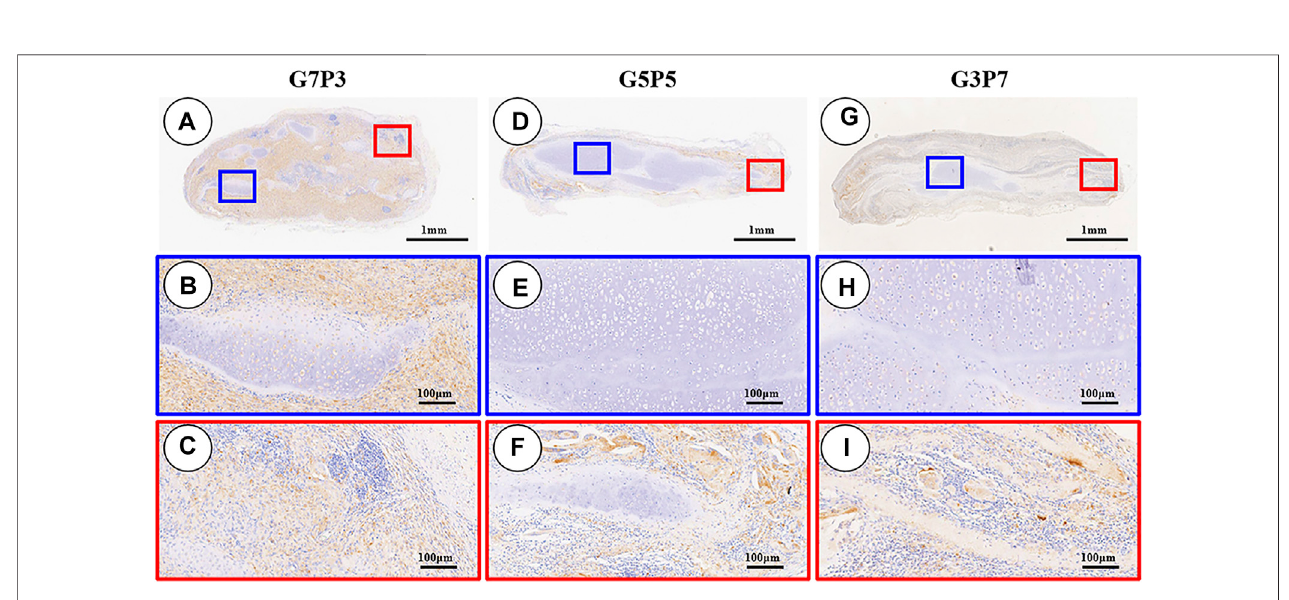
FIGURE 8 | In fl ammatory reaction characterized by CD68 staining. The samples in the G7P3 group show small and sparse cartilage islands surrounded by abundant CD68-positivecells (A – C) .In theG5P5and G3P7groups, CD68-positivecellsare observed in theouter and edge regions but not inthe central regions (D – I) . More CD68-positive cells are observed among layered undegraded scaffolds in the edge regions of the G3P7 group (I) compared to the G5P5 group (F) .